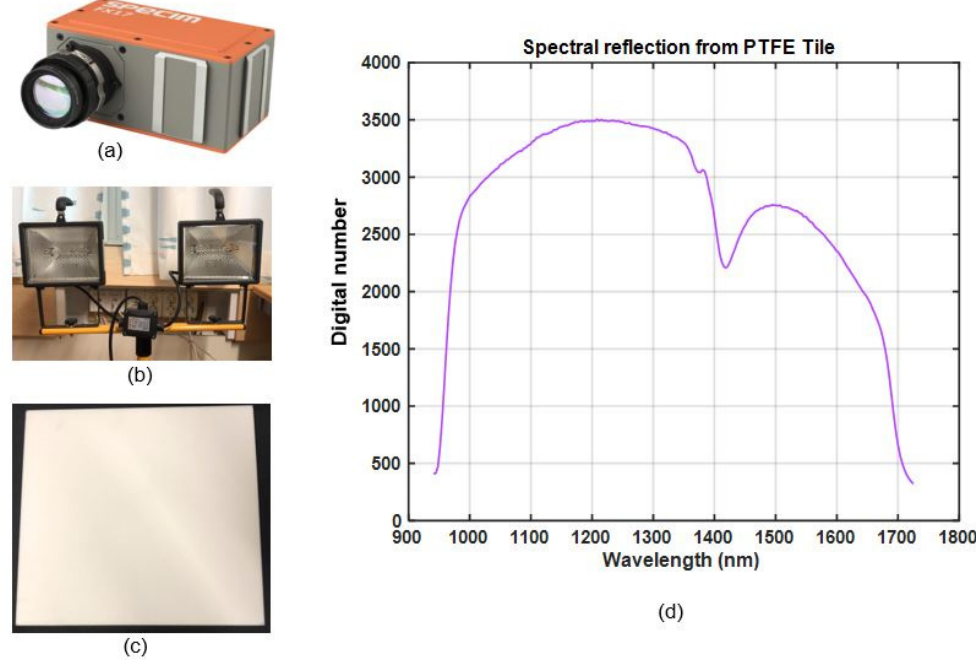
Figure 2. Materials used in the research: ( a ) Specim FX17e hyperspectral camera, ( b ) two halogen lamps mounted on a tripod, ( c ) PTFE tile, ( d ) average intensity of spectra for the PTFE tile.